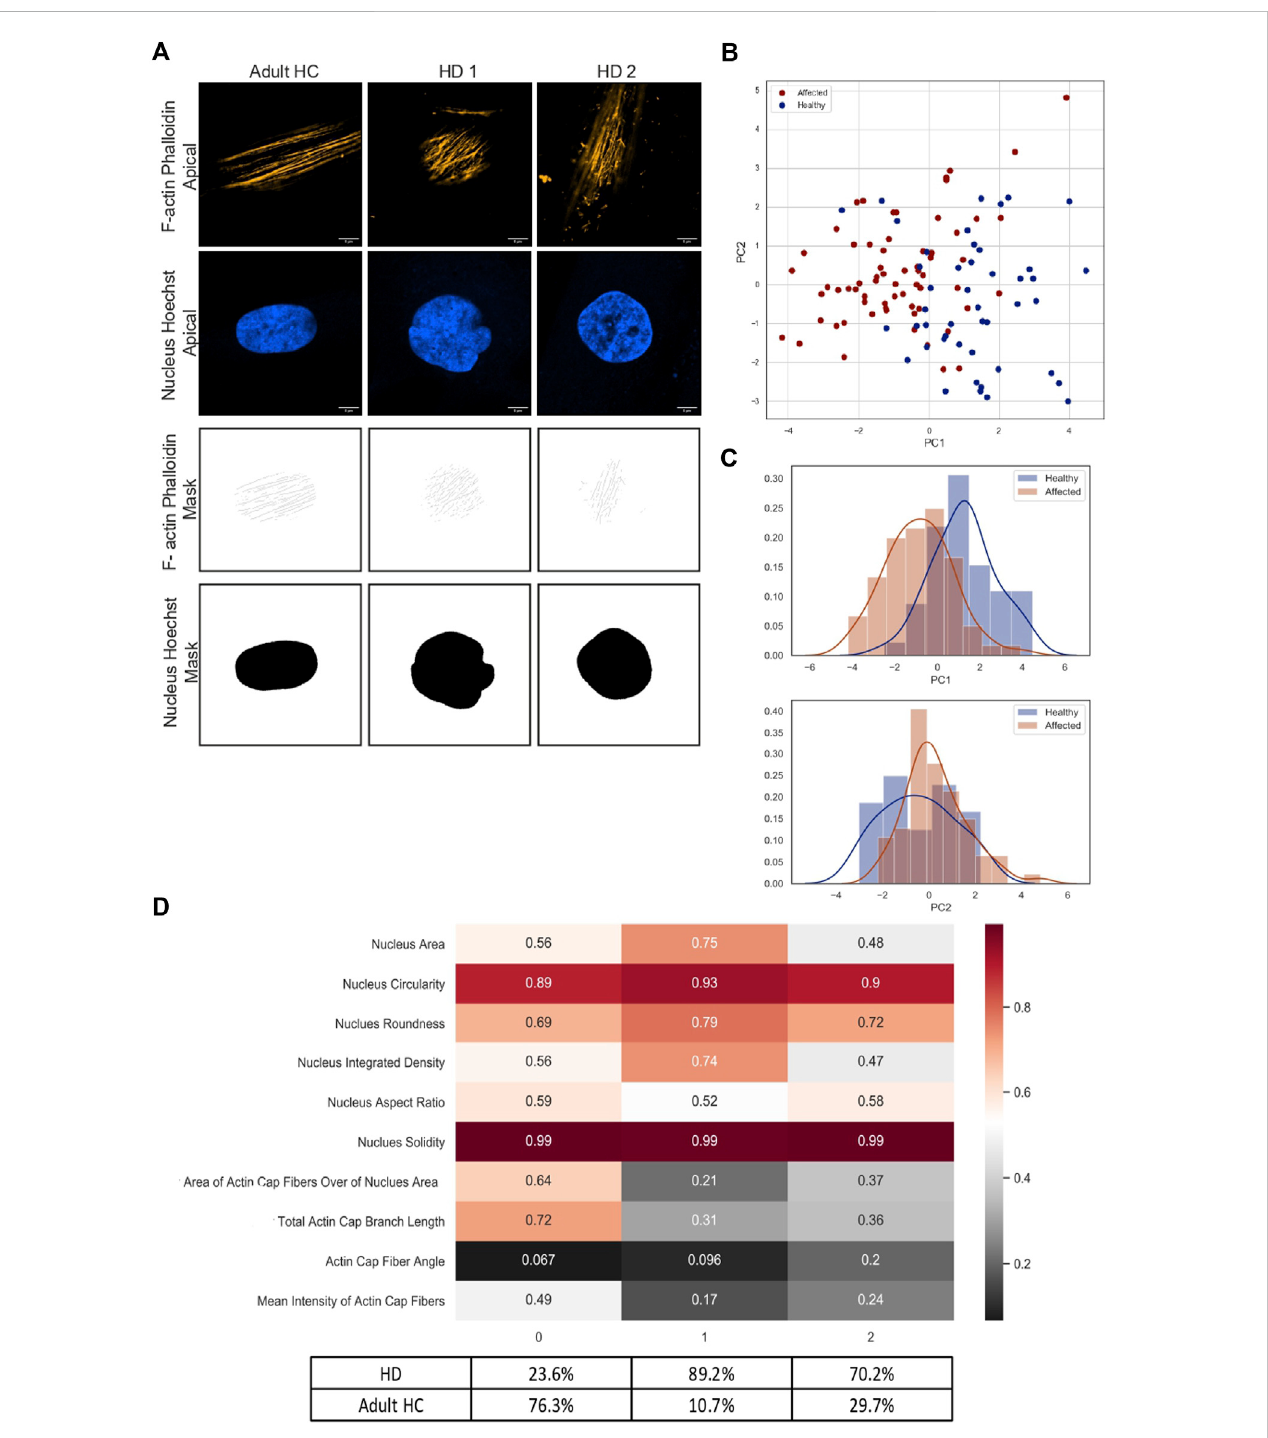
FIGURE 3 Deeper analysis for the different actin cap morphologies in HD skin fi broblast cells (A) Representative confocal immuno fl uorescence staining images of data acquired under 63x magni fi cation 1.4NA objective and Airyscan module. Cells were stained with Hoechst to label the cell nuclei and phalloidin to label actin fi laments of fi xed cells. Scale bar = 5 μ m For analysis of different morphological clusters of actin cap, for each skin fi broblast cell 3 images were acquired – basal nucleus, apical nucleus, and apical actin. Representative Images of the segmented actin cap fi bers and nucleus generated by the WEKA trainable segmentation tool. (B) PCA analysis of 8 HD vs. 8 HC actin cap and nucleus morphological features. The analysis shows a signi fi cant separation between the two groups. Each sample is represented by 10 morphological features extracted from 1 cell, in total ~50 cells from each population, blue circles represent HC samples, red circles represent HD samples (C) Histogram graphs represent the distribution of the analyzed PCA data of the two populations in the two dimensions (PC1, PC2), blue histogram represents HC and red histogram represents HD (D) K-means analysis of three clusters of the same data analyzed by PCA in (B) . The values in the plot are the average of the different values of one measurement in speci fi c cluster. Cluster 0 accumulated mainly by HC (Class0: 76.3% HC, 23.6% HD) and Cluster 1, and 2 accumulated mainly by HD cells (Cluster 1: 89.2% HD, 10.7% HC; Cluster 2: 70.2% HD, 29.7%